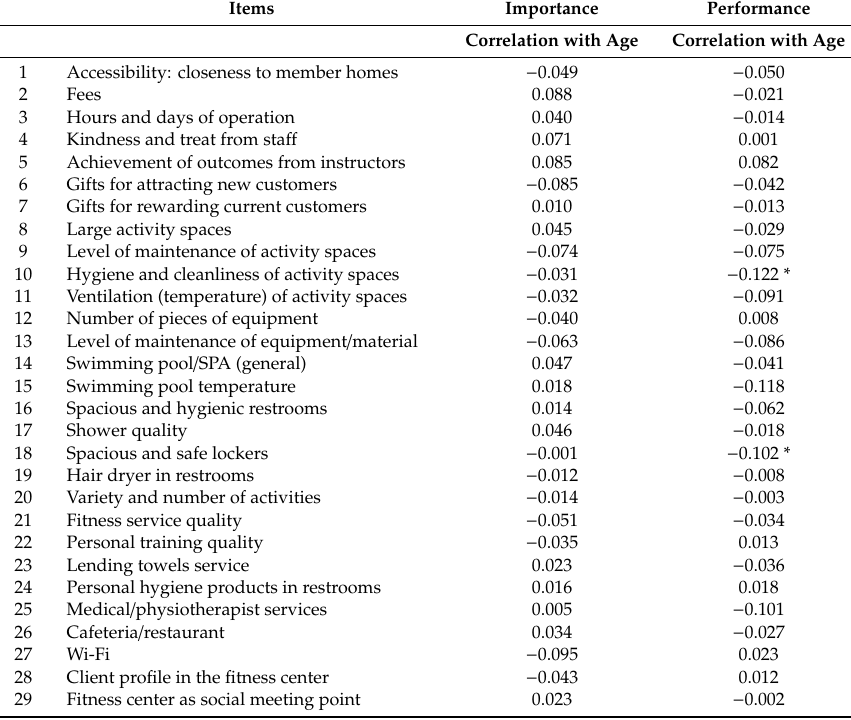
Table 4. Age correlation with importance and performance scores.